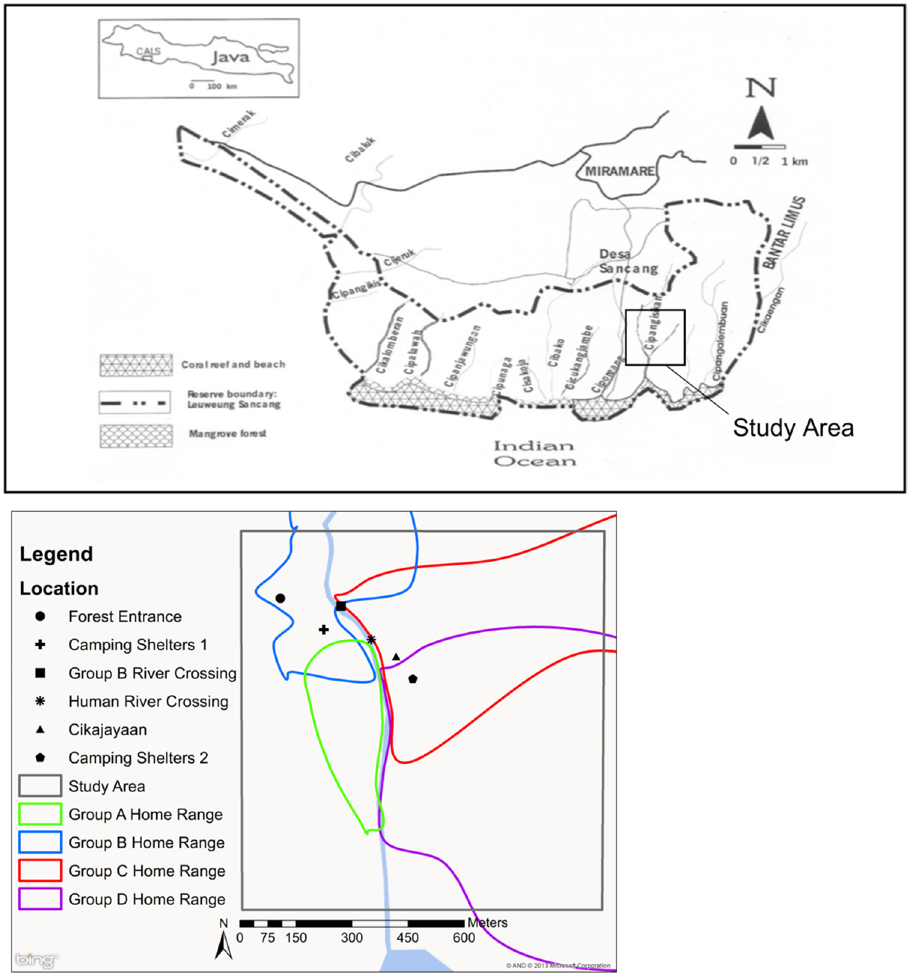
Figure 1. Map of CALS [44] with study area along Cipangisikan River highlighted. Approximate home ranges of study groups are shown on map. Note that home ranges extend beyond study area and home ranges represented outside of study area are estimated. Significant locations within study area are noted on the map.